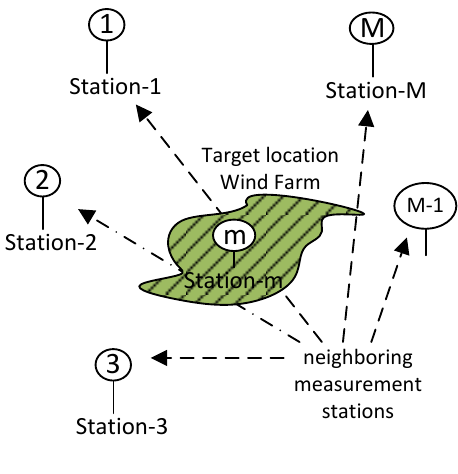
Figure 1. Multi-channel wind data measurement stations around the target